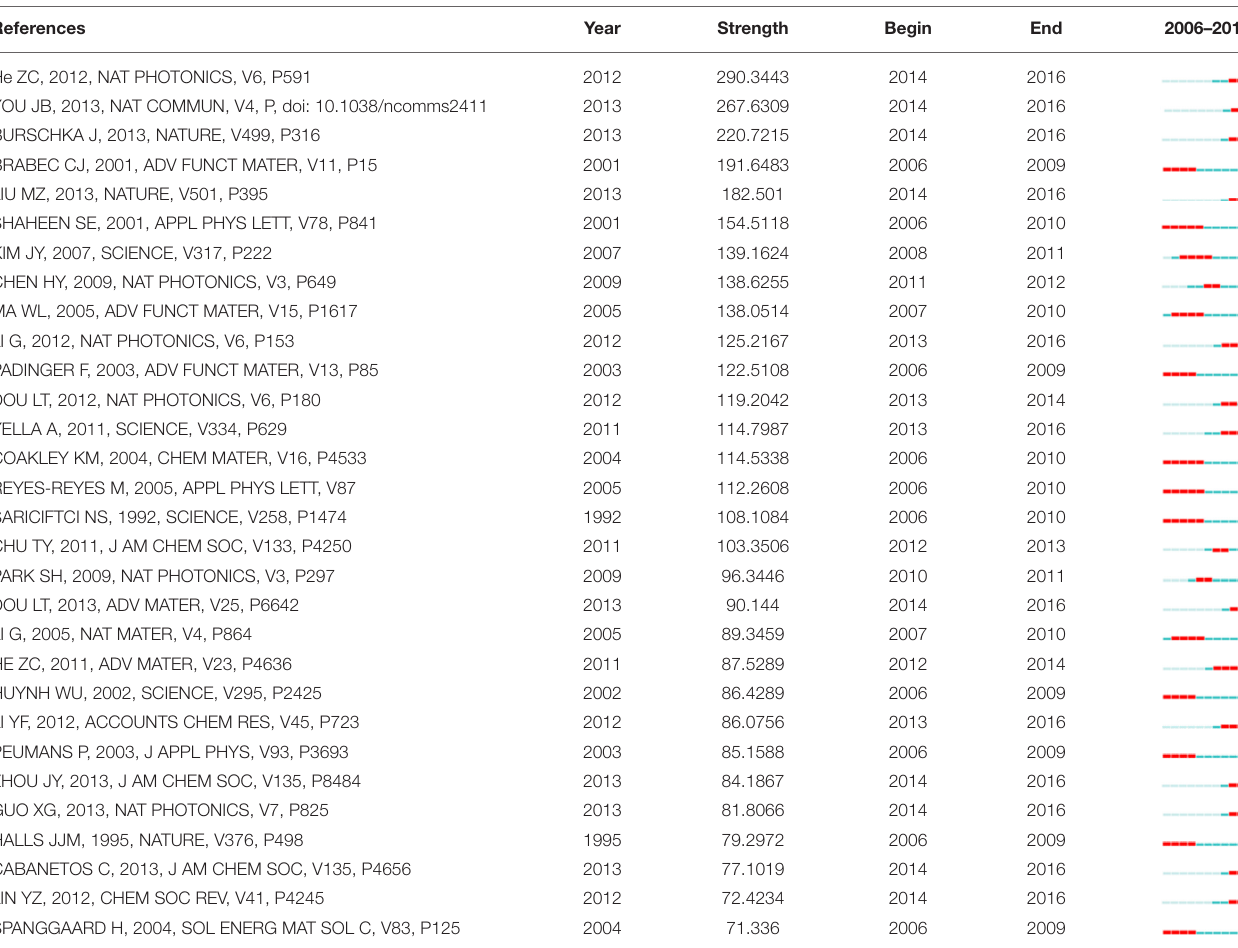
TABLE 4 | Top 30 references with strongest citation